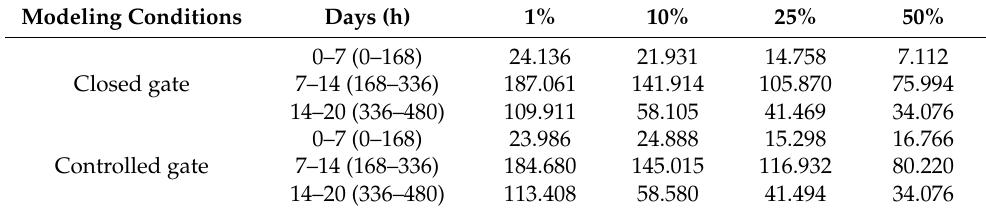
Figure 15. Flood duration map of the 2019 flood hydrograph simulated on DEM with changes (pro- ject scenario).